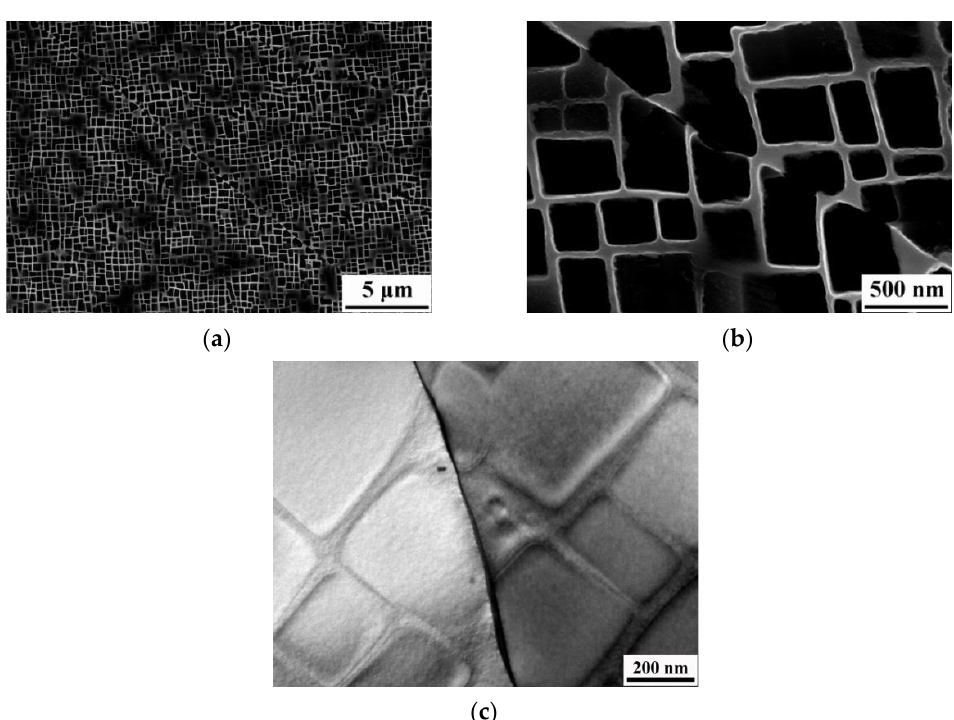
Figure 3. Microstructuresof LABs of 3.7° in DD9 alloy after heat treatment: ( a ), ( b ) SEM morphologies; ( c ) TEM morphologies.